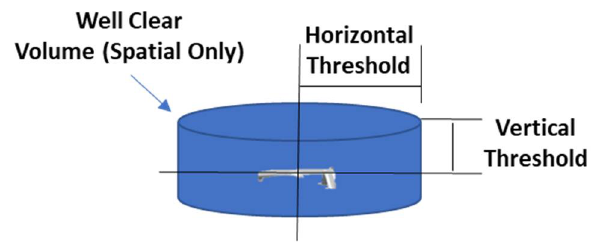
Figure 6. Shape of the spatial only Well Clear volume.